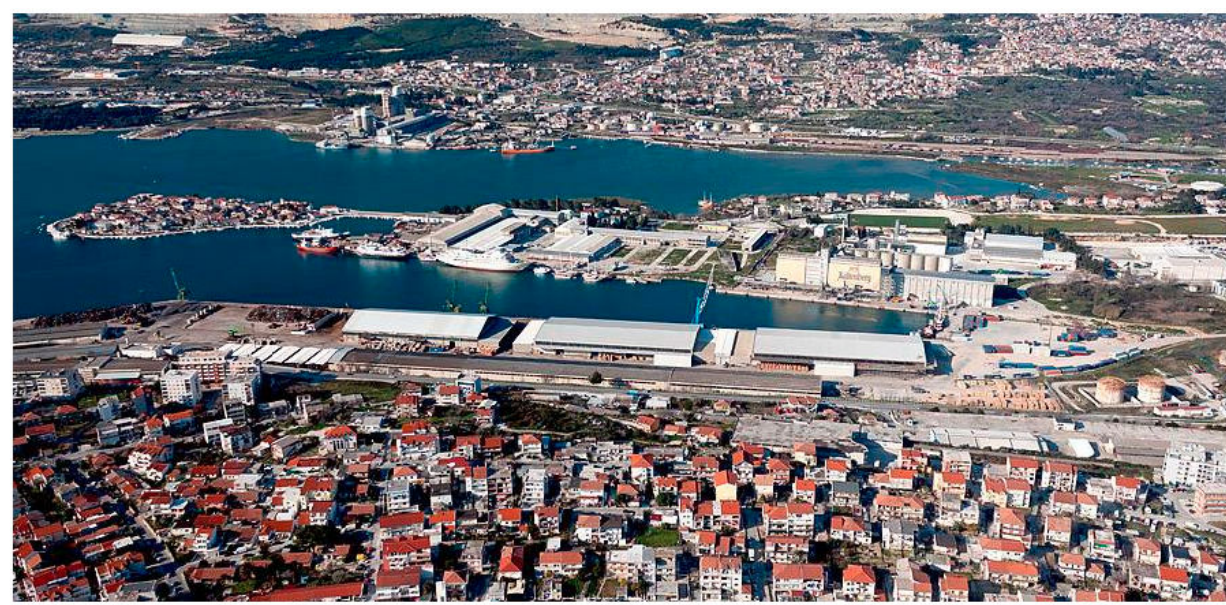
Figure 3. Aerial view of the cargo terminal in the port of Split